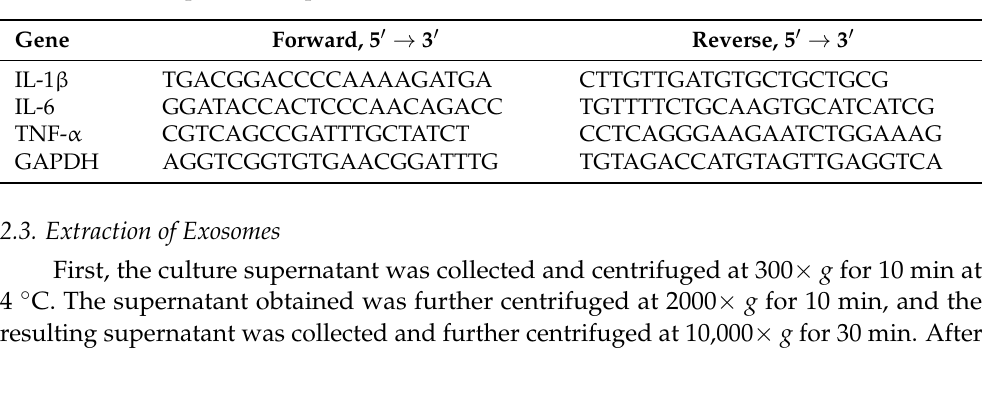
Table 1. Primer sequences for